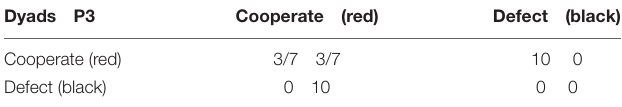
TABLE 1 | The PD matrix in the